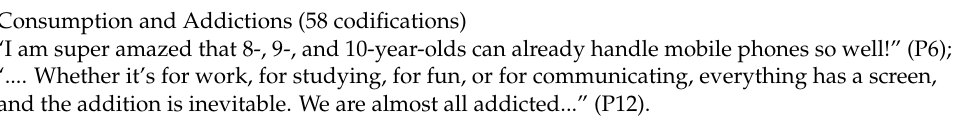
Table 2. Summary table: Voices of Cascais’ Youth .